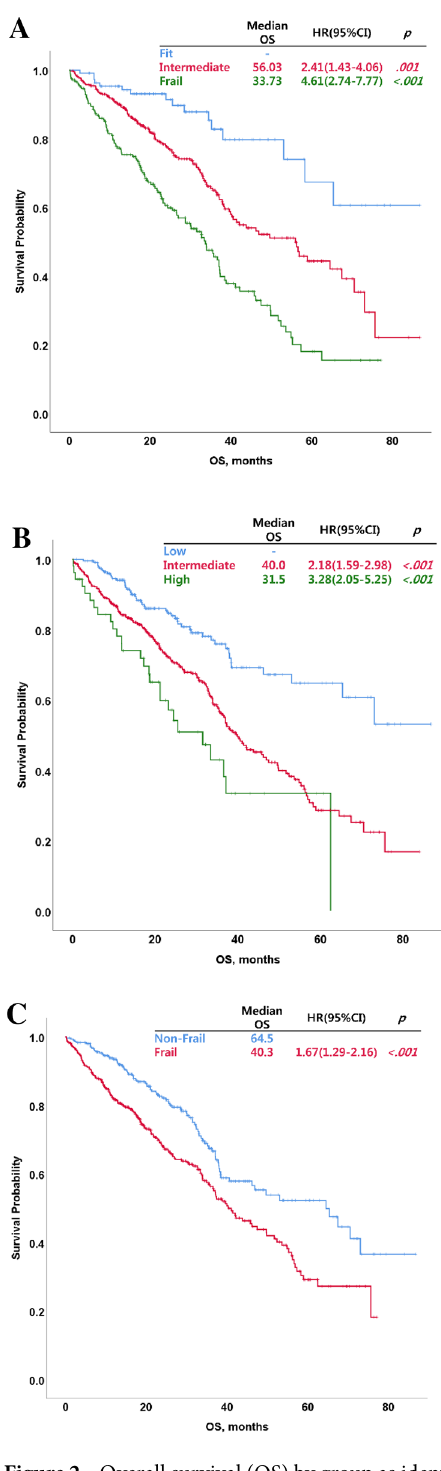
Figure 2. Overall survival (OS) by group as identified using different frailty assessment tools. OS of groups classified using the new clinical frailty index ( A ), revised myeloma comorbidity index ( B ), and simplified frailty scale ( C